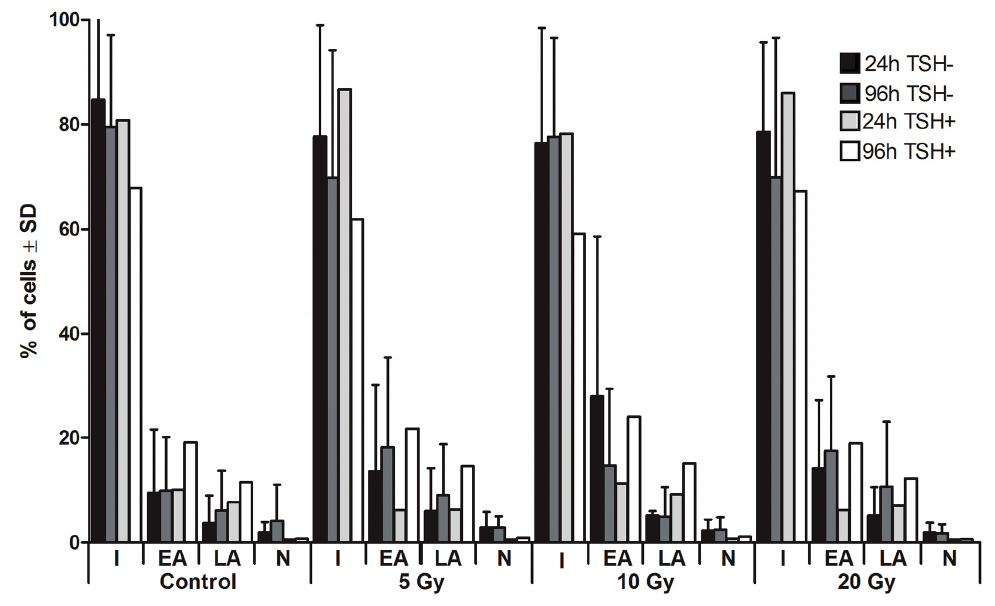
Figure 1. Survival of human thyrocytes in culture with 131 I. The graph presents the percentages (±SD) of thyrocytes undergoing apoptotic or necrotic death processes, as assessed by flow cytometry directly after 24 h of 131 I exposure (5, 10, 20 Gy) or after additional 72 h of culture without 131 I. The culture was performed parallel with or without Thyroid stimulating hormone (TSH) stimulation. I—intact cells, EA—early apoptosis, LA—late apoptosis, N—necrosis.